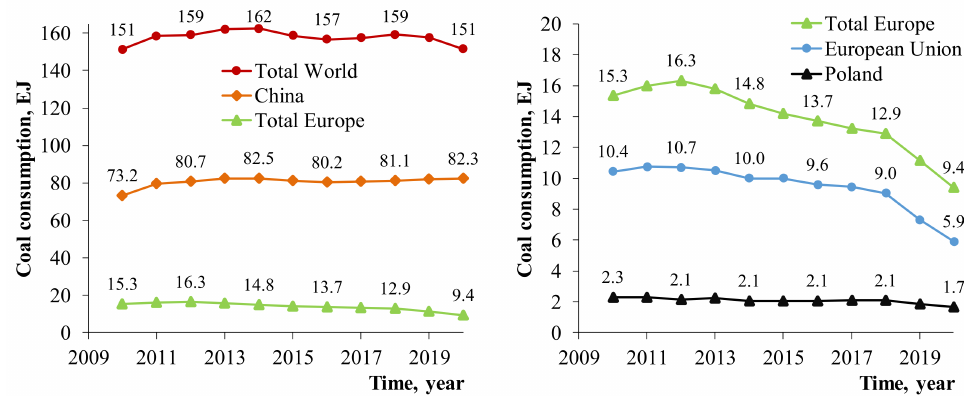
Figure 1. Coal consumption (data source comes from [5]). Table 1. Production of CCPs by country/region [8–10].